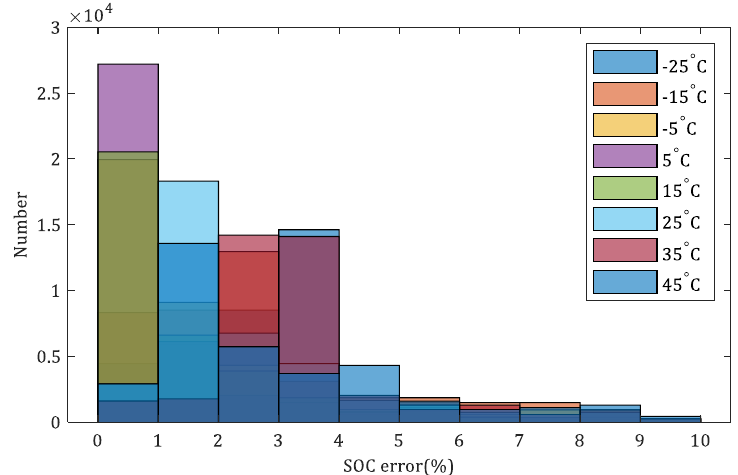
Figure 9. Histogram of SOC estimation error by ERTSS at various temperatures.